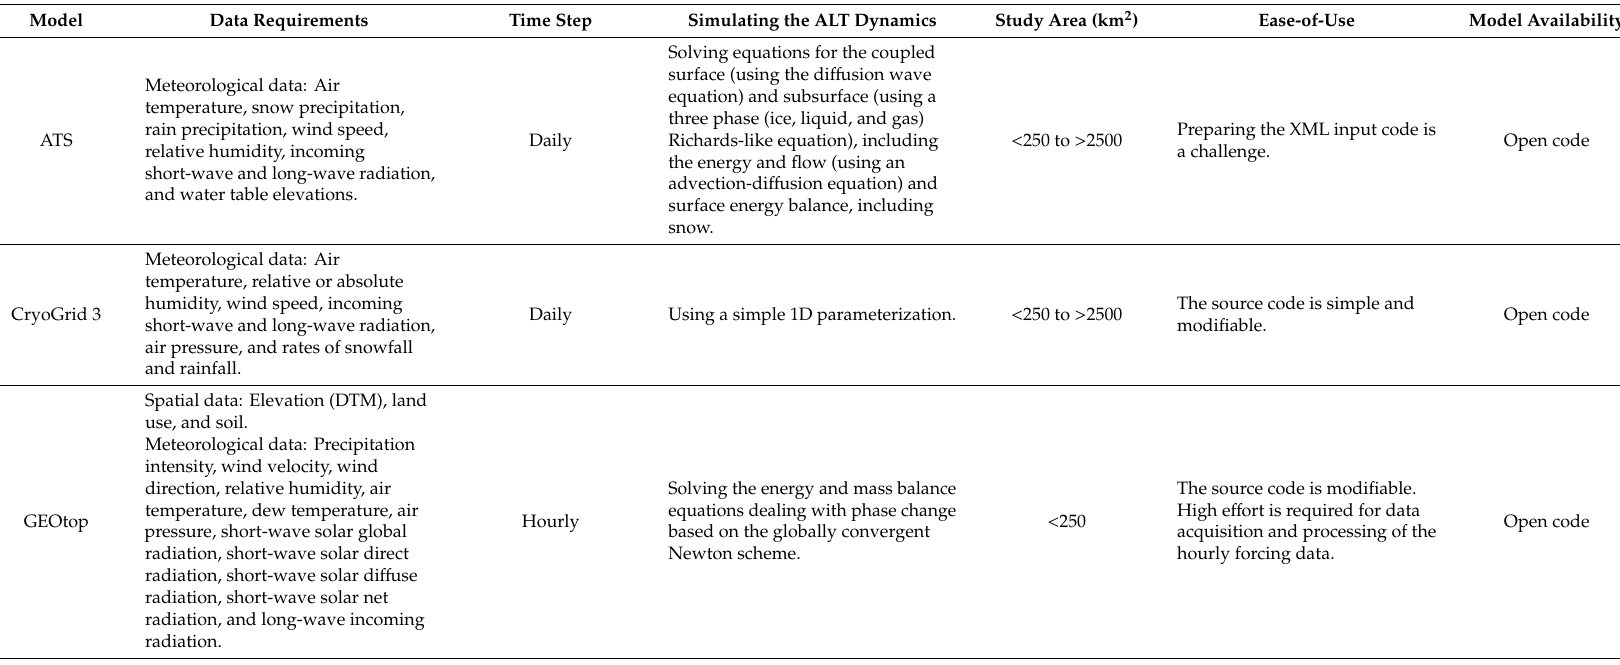
Table 4. Summarization of model comparisons (continued).